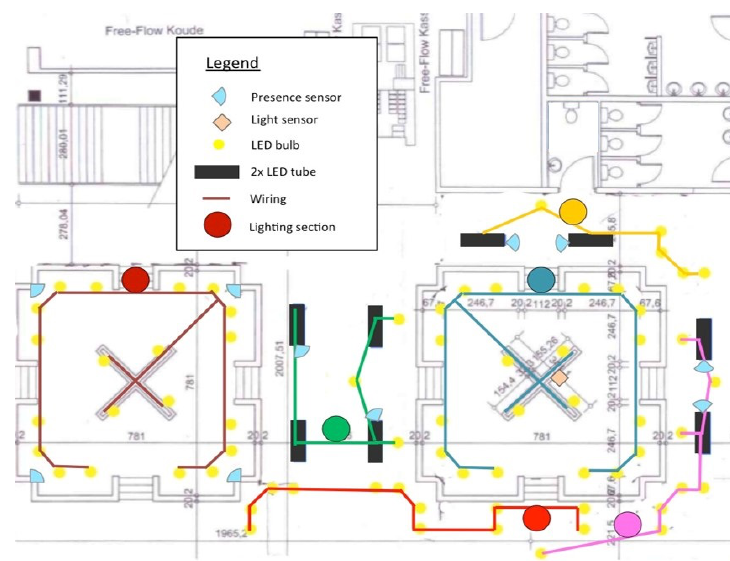
Figure 13. Floor plan of the lighting zones, sensors and lamps in the Vrije Universiteit Brussel restaurant EDISON